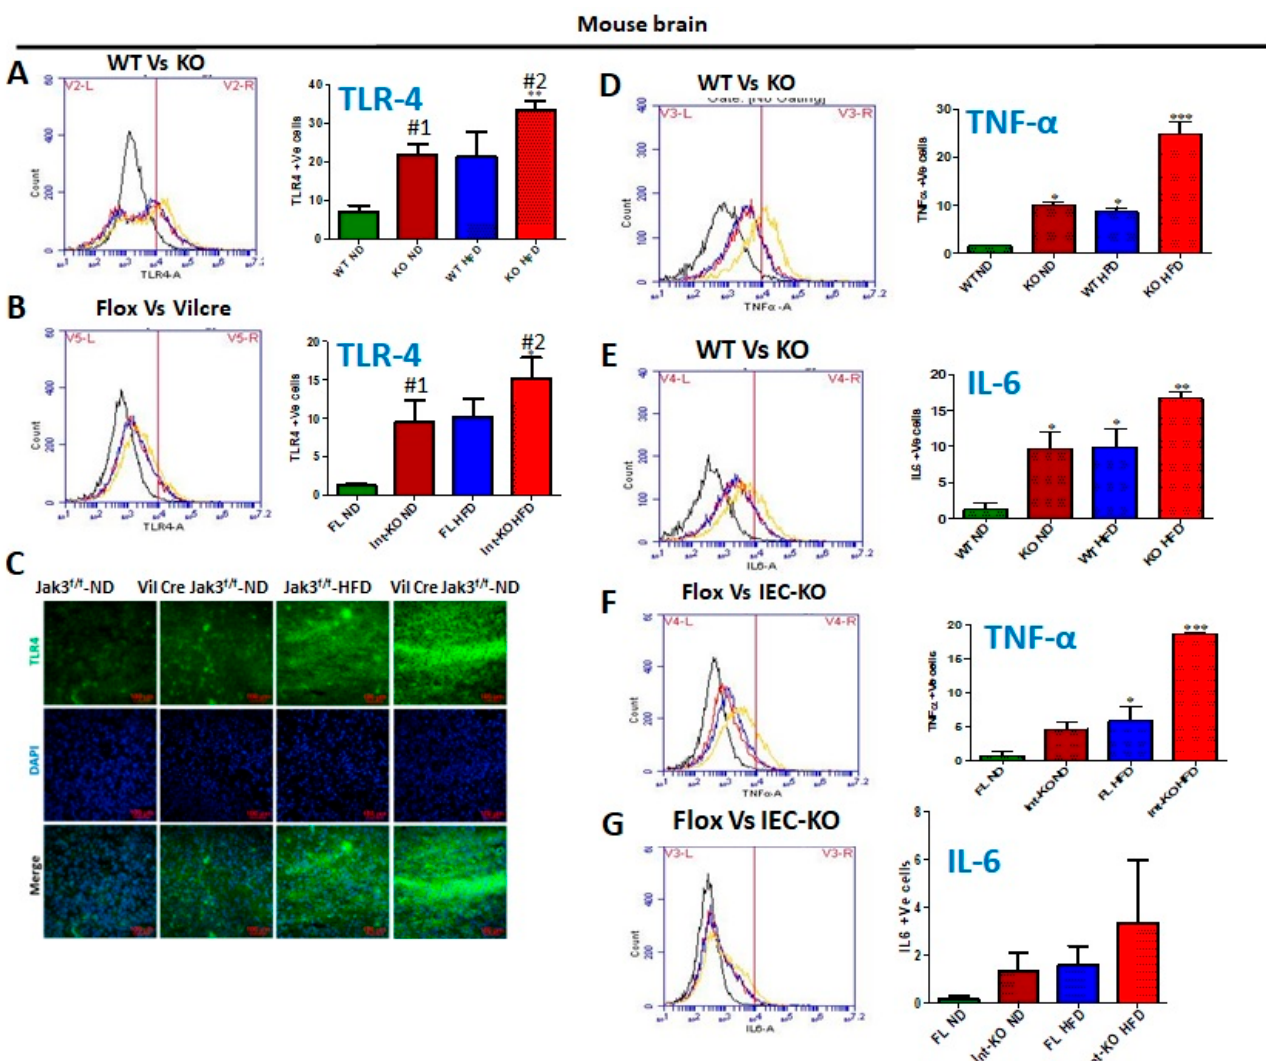
Figure 6. HFD-led suppression of Jak3 promotes brain inflammation through microglial activation and increased TLR4 signaling. Global ( A , D , E ) or intestinal epithelial ( B , F , G ) deficiency of Jak3 leads to increased TLR4 expression and inflammation in the brain. Representative flow cytometric histogram graphs of individual mouse brain cells showing the levels of expression of TLR-4 ( A , B ) and inflammatory cytokines TNF- α ( D ,F) and IL-6 ( E , G ) in the four indicated groups of global Jak3 deficiency or IEC Jak3 deficiency, respectively ( n = 5/group), are shown in the left panel, and the corresponding histogram bar graphs indicating mean ± SD values in the right or lower panels are shown for the comparative average cell counts for the indicated groups of mice. *, **, *** Indicate statistically significant difference from the corresponding controls (A: KO-ND#1 p = 0.04, KO-HFD#2 p = 0.07; B: IEC-KO-ND#1 p = 0.05, IEC-KO-HFD#2 p = 0.05; D: KO-ND p = 0.03, WT-HFD p = 0.01, KO-HFD p = 0.02; E: KO-ND p = 0.03, WT-HFD p = 0.01, KO-HFD p = 0.02; F: FL-HFD p = 0.06, IEC-KO-HFD p = 0.02)). ( C ) Brain tissue sections from flox-Jak3-control littermate and IEC-Jak3-KO mice fed with either ND or HFD were immunostained using TLR4 primary antibodies followed by FITC secondary antibodies, and mounting media containing PI were used to visualize the nucleus. Representative images ( n = 10) are shown.